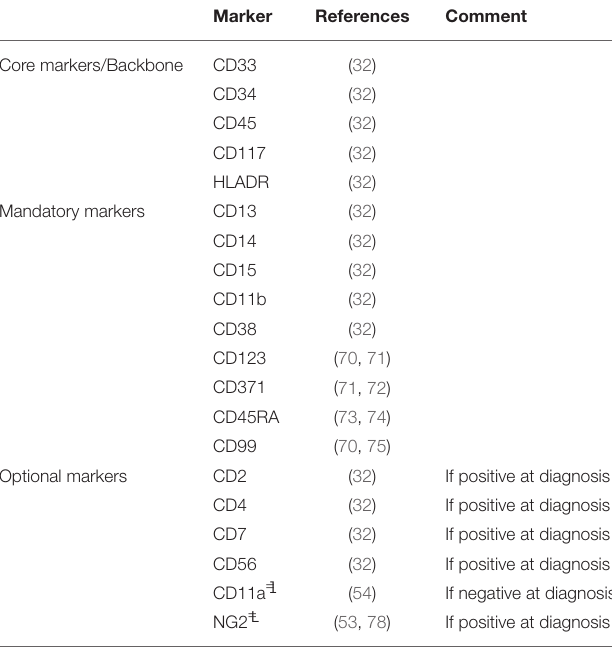
TABLE 2 | Markers for MFC-MRD in AML.